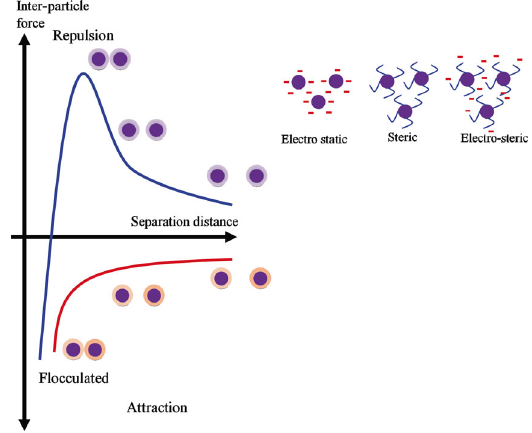
Fig. 2 Schematic diagram of the inter-particle interactions and forces between ceramic